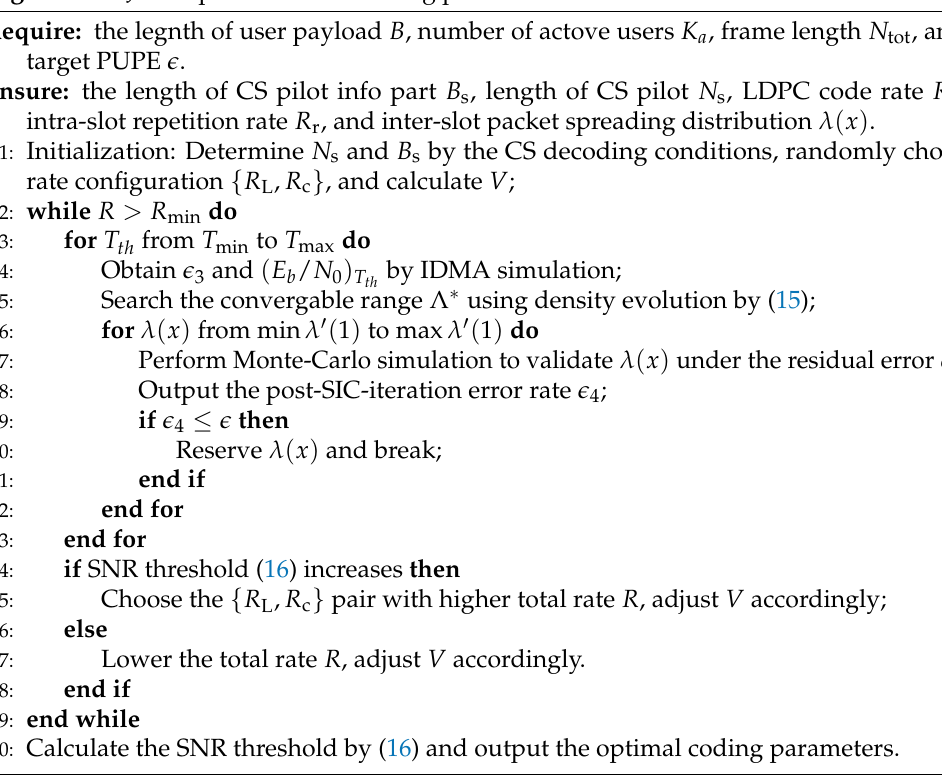
Algorithm 2 Joint optimization of coding